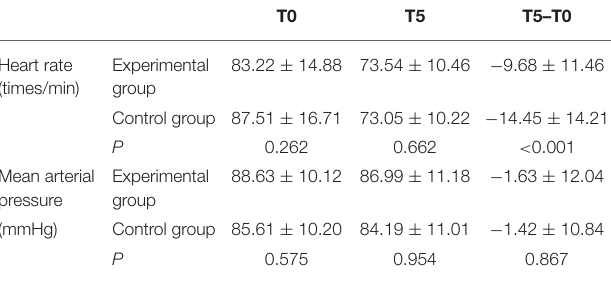
TABLE 4 | Intraoperative haemodynamic